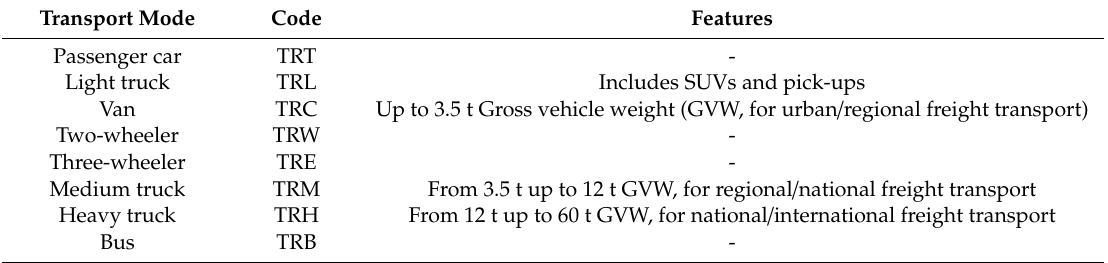
Table 1. Transport modes of the road transport processes, and associated features. The code is composed by three letters: TR stands for transport; the third letter uniquely identifies the transport mode.